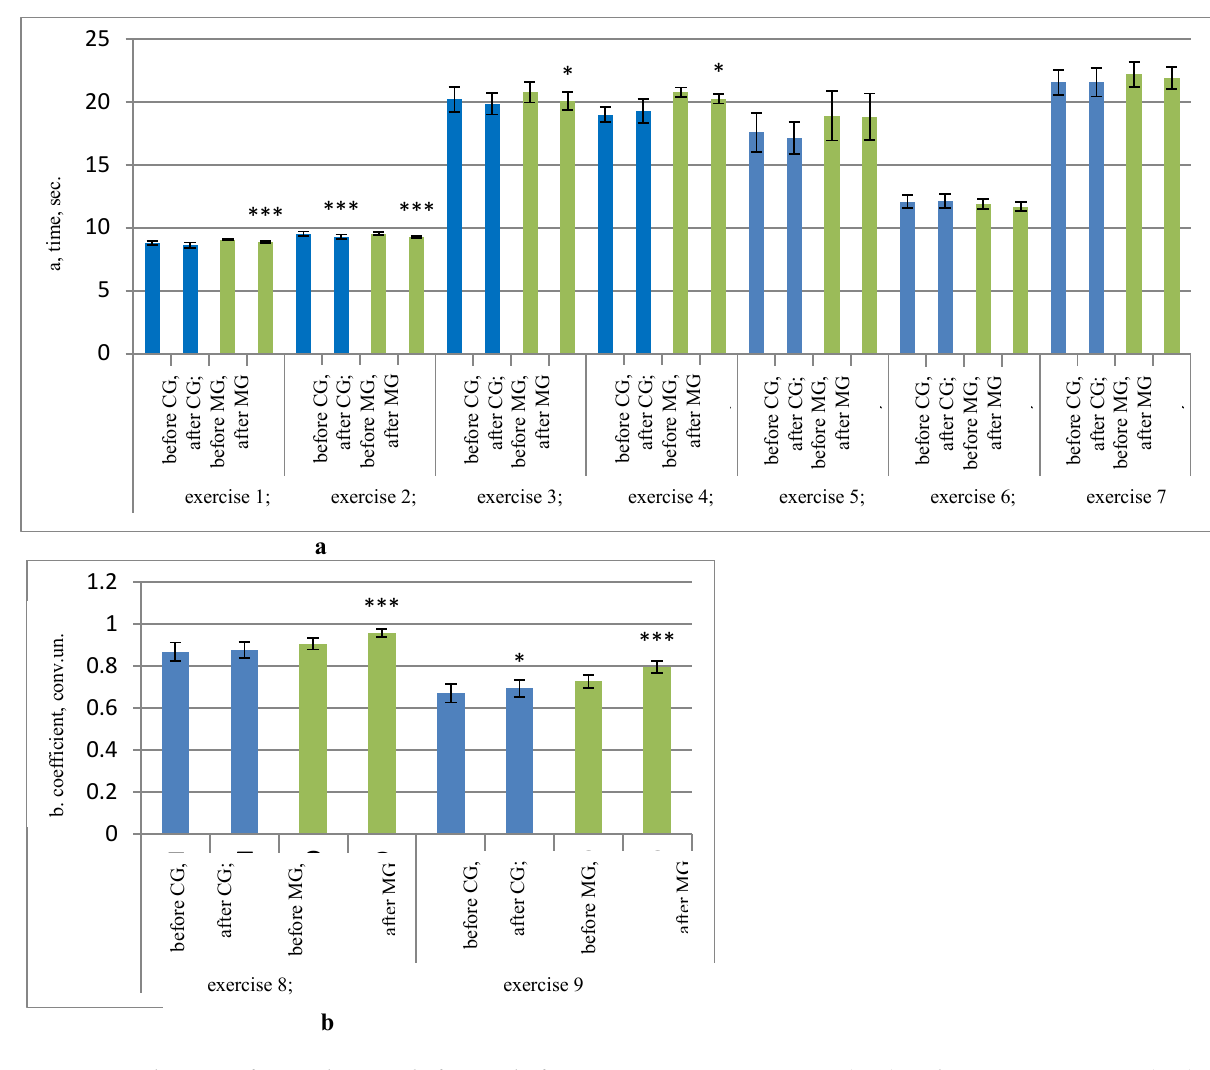
Fig.10. Indicators of control testing before and after experiment in main group (MG) and comparative group (CG), cluster “lactate”: a) a-lactate orientation; b) “lactate” orientation. (р ≤0.001). CG – comparative group; MG – main group.